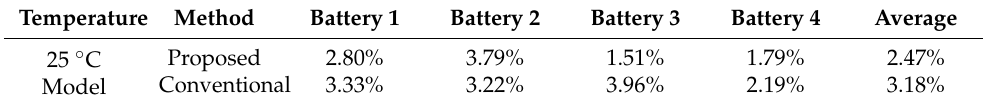
Table 8. The SOC errors obtained using the GRU model generated by the proposed